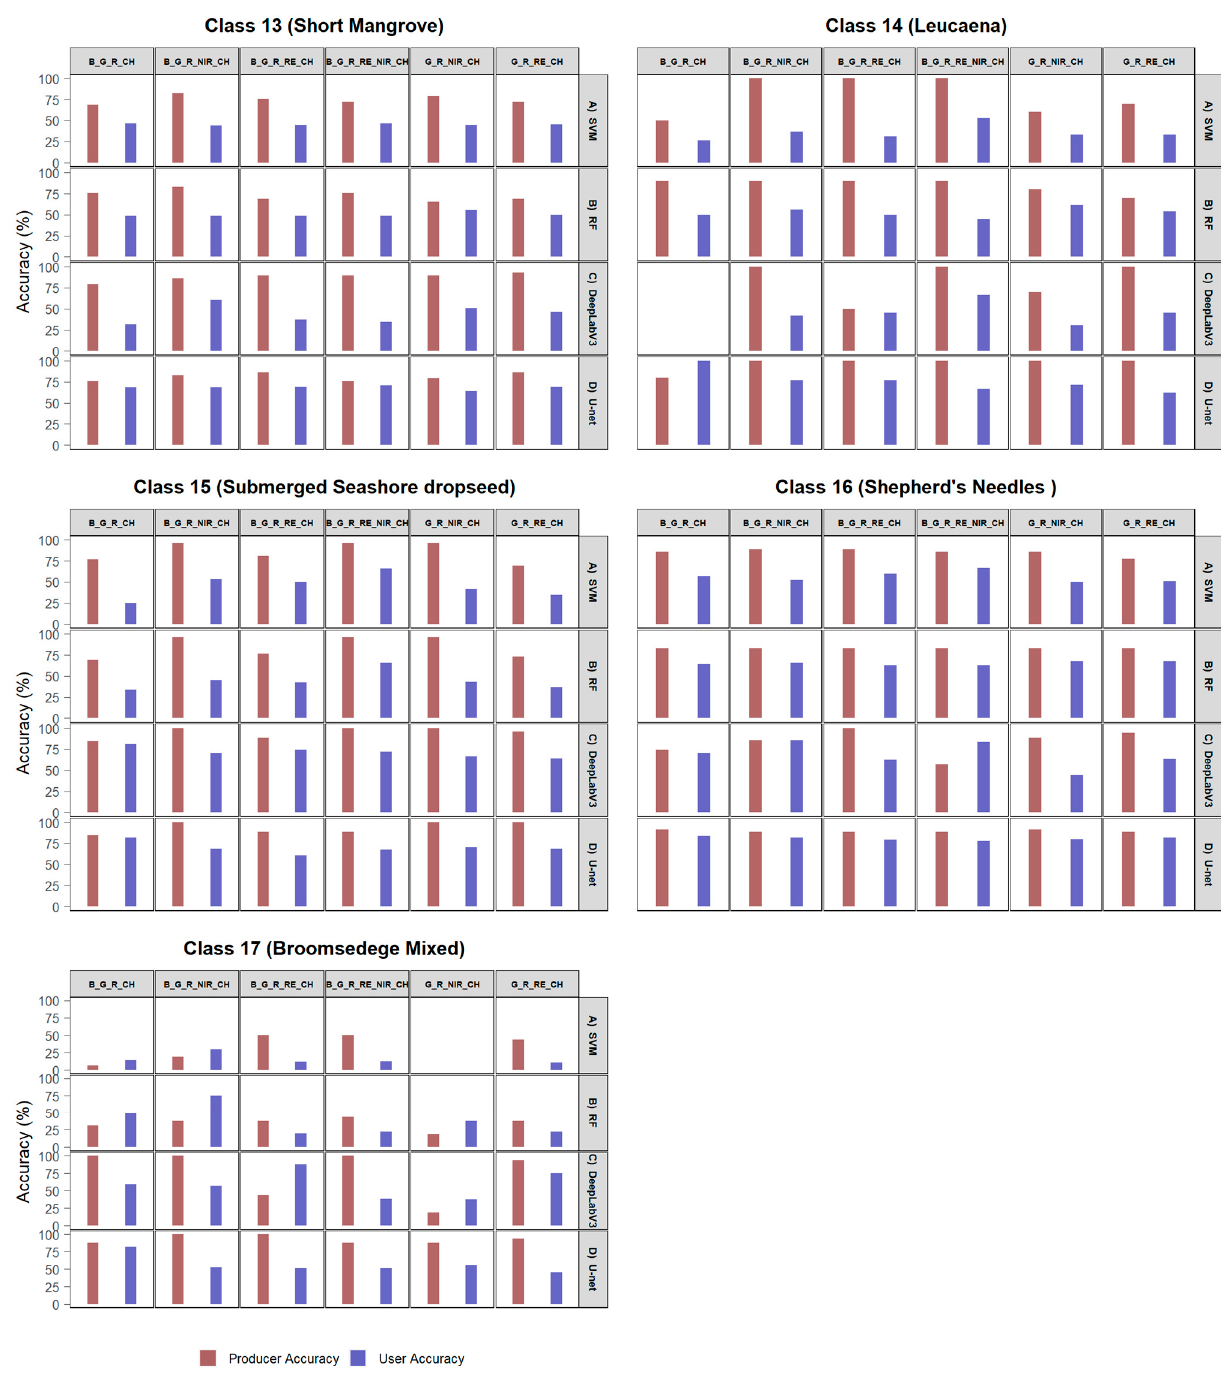
Figure A6. Experiment: EXP2-SB_AB_CHM, producer and user accuracy organized by class and classification method, classes 13 to 17.